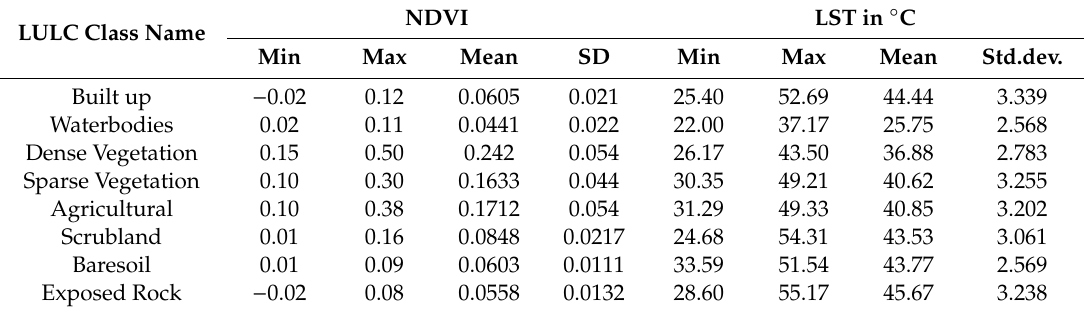
Table 2. The LST and NDVI and their SDs in various LULC class, calculated through zonal statistics analysis using